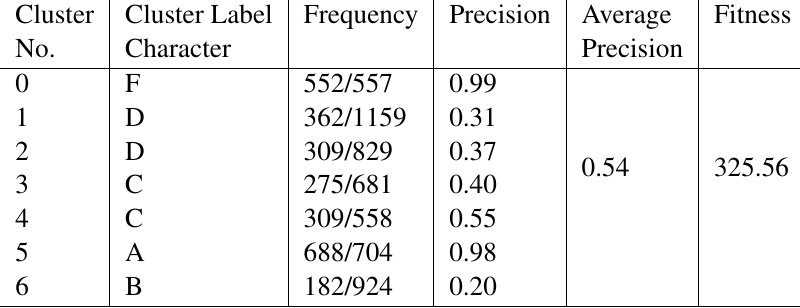
Table 5: K-means algorithm clustering for characters from A to G.